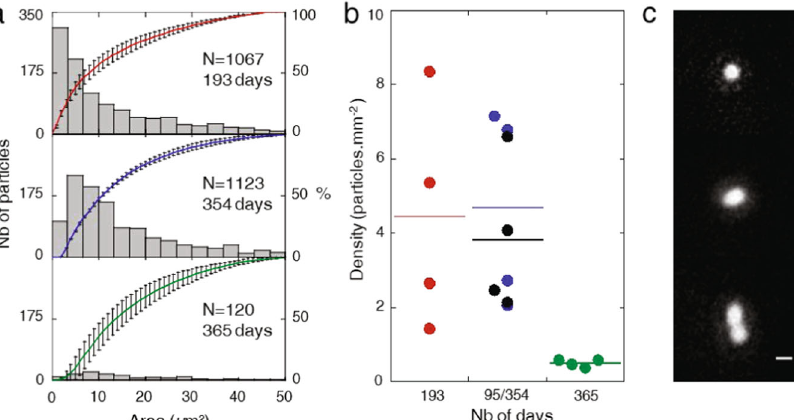
Fig. 2 Surface contamination kinetics by fi ne particles (0.50 < Area < 50 µm 2 ) on FDTS coating. a Particle size distribution histogram (grey bars) versus the area in μ m² and cumulative particle size curves for MATISS-1 (193 days of exposure (red)), MATISS-2 (354 days (blue)) and MATISS-2.5 (365 days (green)) campaigns. Each holder has its symbol. Error bars represent the standard deviation of the data. b Dot-plots showing the density values of the fi ne particles measured on surfaces of 8 x 8 mm. Centerlines show mean values: 4.45 ± 2.66 for MATISS-1 (193 days), 4.68 ± 2.30 for MATISS-2 (354 days) and 1.02 ± 0.58 for MATISS-2.5 (365 days). For MATISS-2, the density values (black) measured on surfaces exposed for 95 days with the same experiment for 354 days are also reported. The black centerline shows a mean value of 3.82 ± 1.77 after 95 days. c Mosaic of optical images recorded at high magni fi cation displaying typical shapes of fi ne particles (scale bar is 2 μ Supplementary Fig. 2 in Lemelle et al. 2020 45 ) in the MATISS-1 campaign were overrepresented compared with the round or angular particles in the MATISS-2 and MATISS-2.5 campaigns (Supplementary Fig. 3). In comparison, very few particles larger than 1500 µm were observed. The shapes of the MATISS-2.5